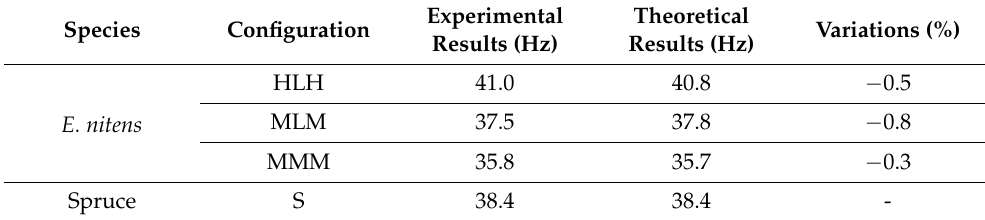
Table 7. Adjusted results of the fundamental natural frequency.